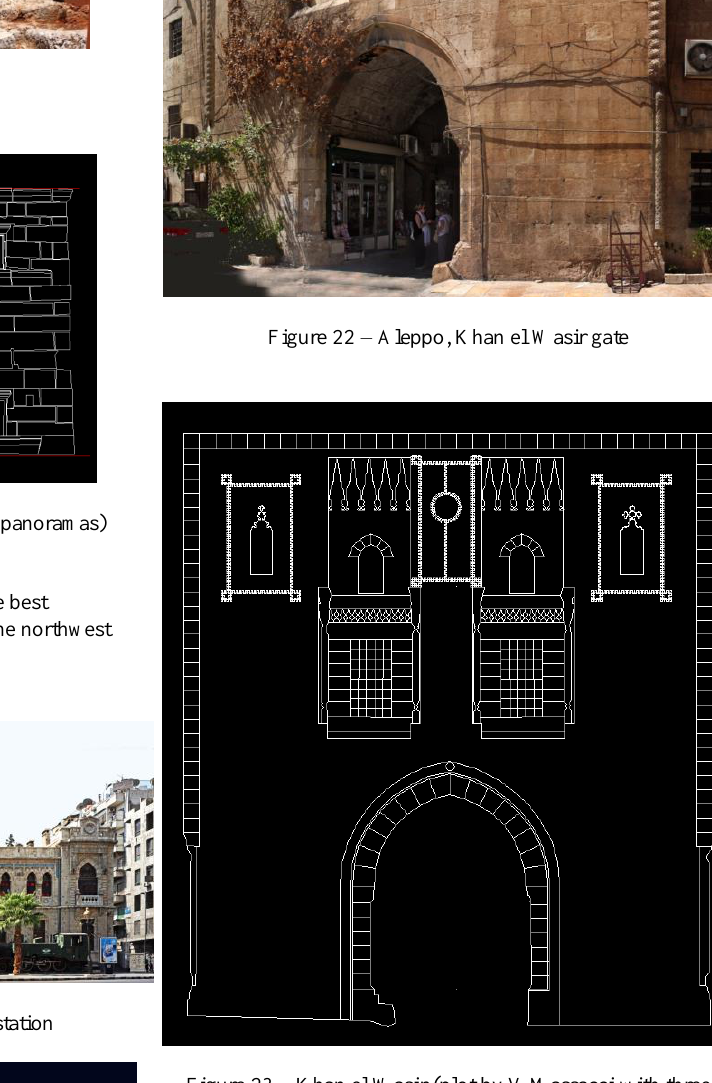
Figure 23 – Khan el Wasir (plot by V.Massacci with three